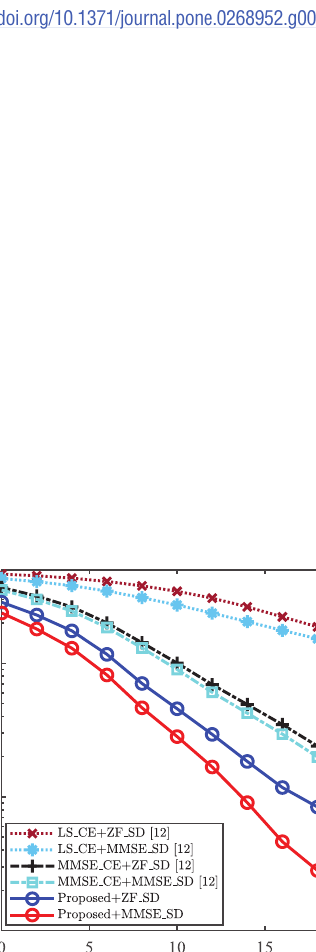
PLOS ONE | https://doi.org/10.1371/journal.pone.0268952 May 27,